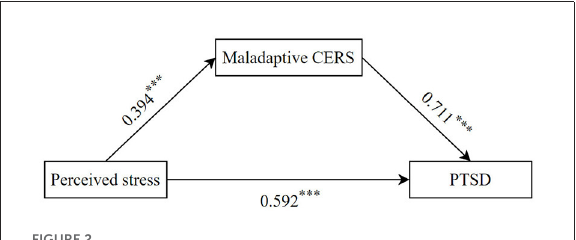
FIGURE2 The mediating effect in the association between perceived stress and PTSD symptoms. *** p <